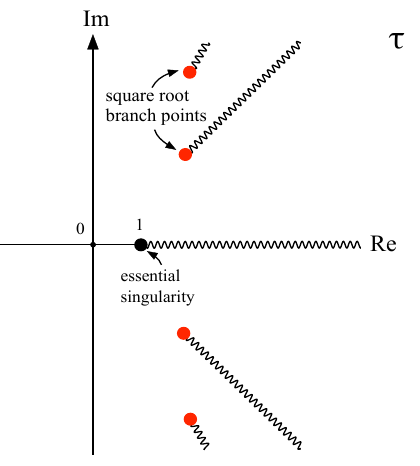
Figure 3 . Singularities and branch cuts in the Borel plane for the ghost number zero tachyon. Since we will be interested in Borel summation, it is convenient to orient the branch cuts so that they extend directly away from the